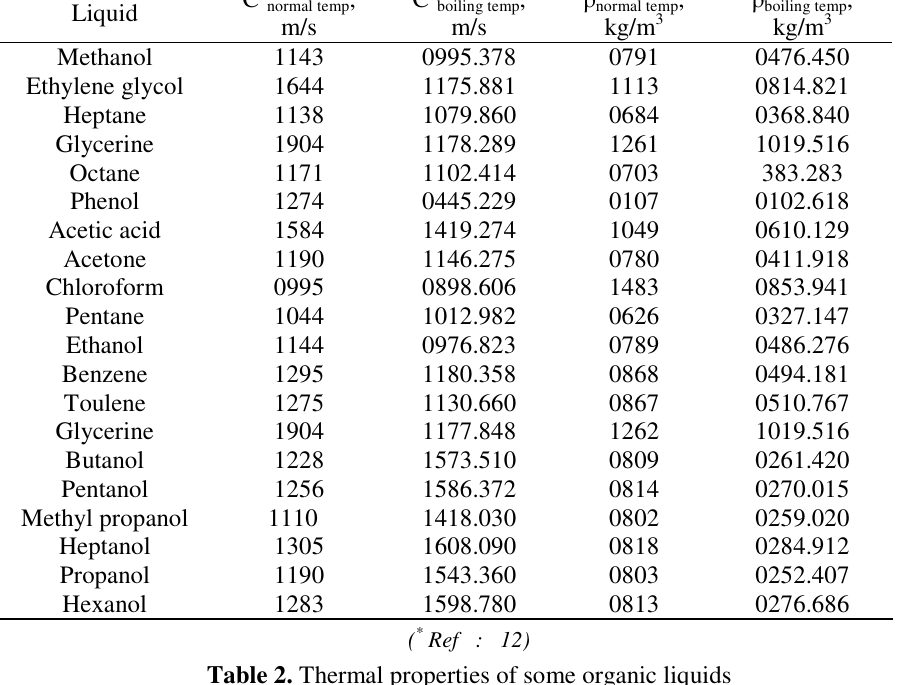
Table 1. Velocity and density of some organic liquids at normal and boiling temperature Liquid